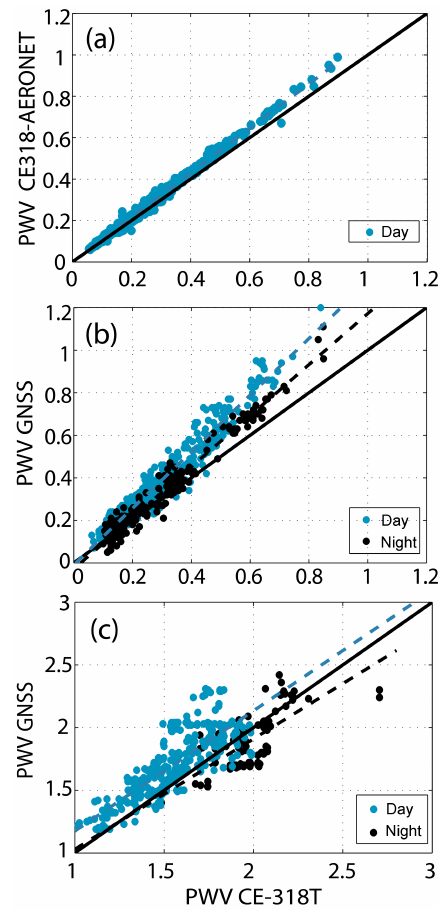
Figure 10. Scatter plot with daytime (in blue) CE318-T master PWV (in cm) vs. (a) CE318-AERONET, (b) daytime and night-time master (black) CE318-T PWVs (in cm) vs. GNSS, and (c) daytime and night-time PWV comparison performed at Granada station us- ing the secondary CE318-T and GNSS ultra-rapid orbits. The dotted line represents the linear regression line and the solid line the 1 : 1 line in all